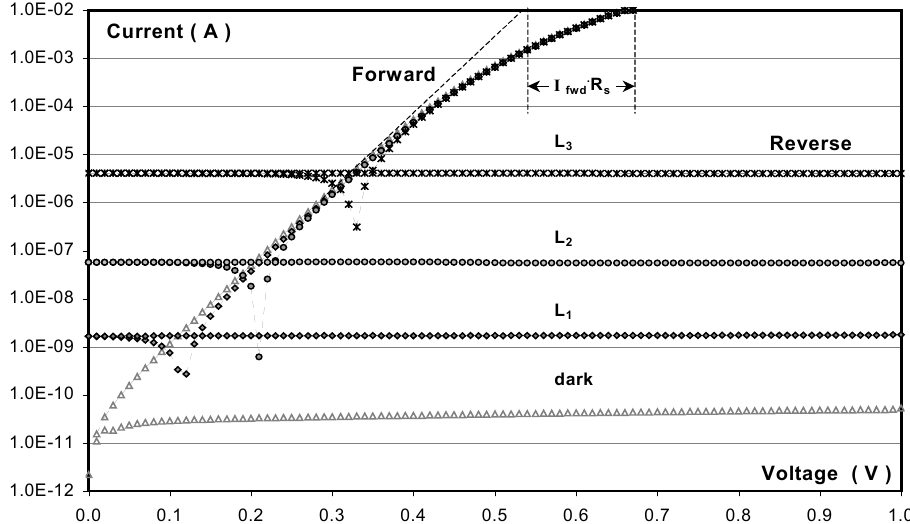
Figure 3. Experimentally obtained I-V curves of an illuminated p-n junction at various incident light power levels, compared to the corresponding response of the same device in the dark. Notice that the reverse bias current increase as the illumination level increases, i.e. dark, L = 0.1 mW/cm 2 , L = 0.3 mW/cm 2 , L = 0.7 mW/cm 2 . The forward bias 1 2 3